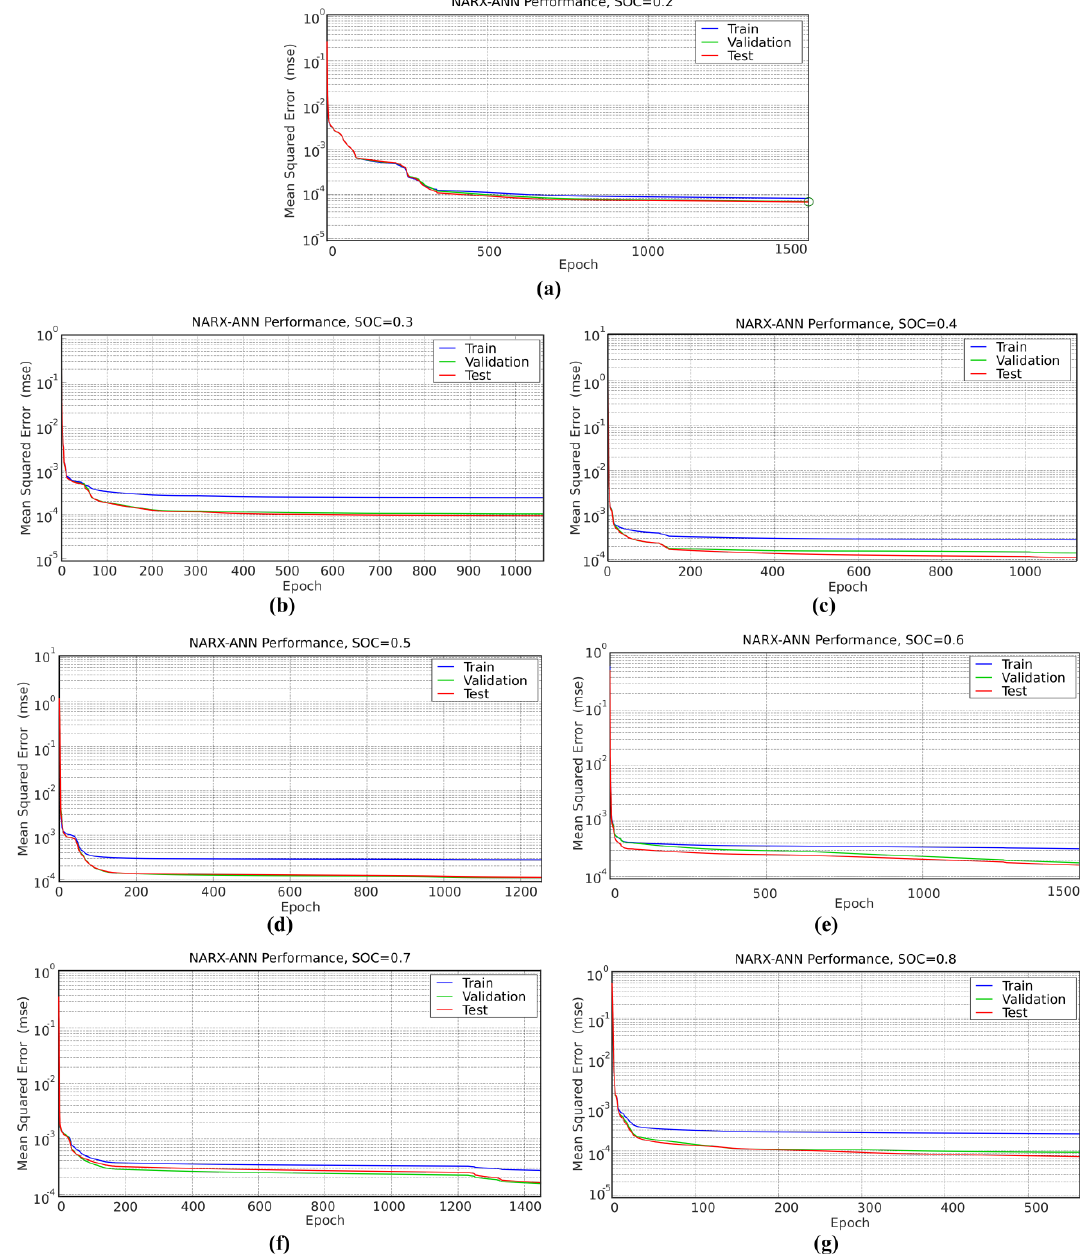
Figure 7. The performance of NARX-ANN models during training, respectively for: ( a ) SOC = 0.2; ( b ) SOC = 0.3; ( c ) SOC = 0.4; ( d ) SOC = 0.5; ( e ) SOC = 0.6; ( f ) SOC = 0.7 and ( g ) SOC = 0.8 in pulse work cycle.